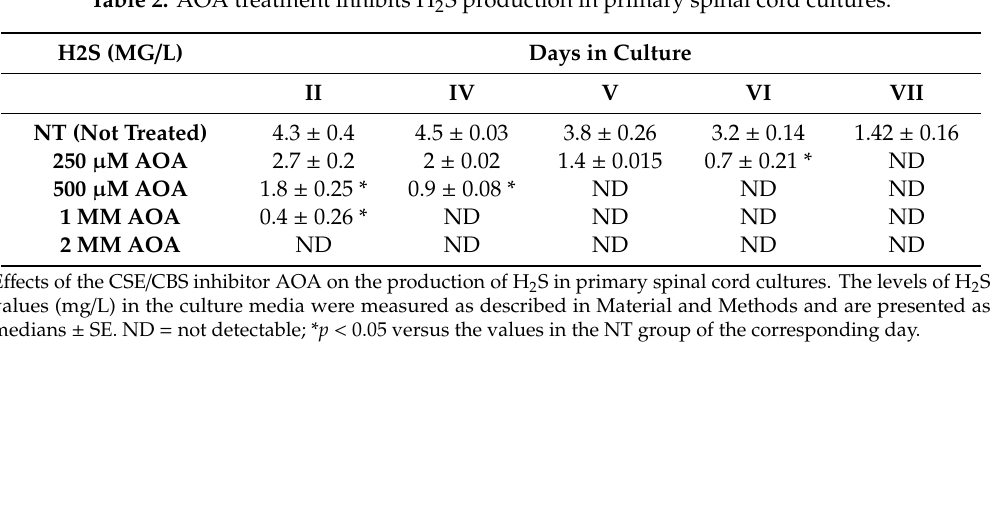
Table 2. AOA treatment inhibits H 2 S production in primary spinal cord